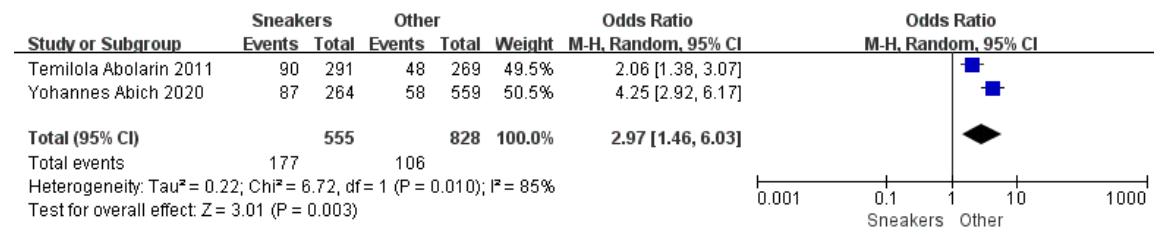
Figure 5. The forest plot of joint relaxation for flatfoot in children [7,14].